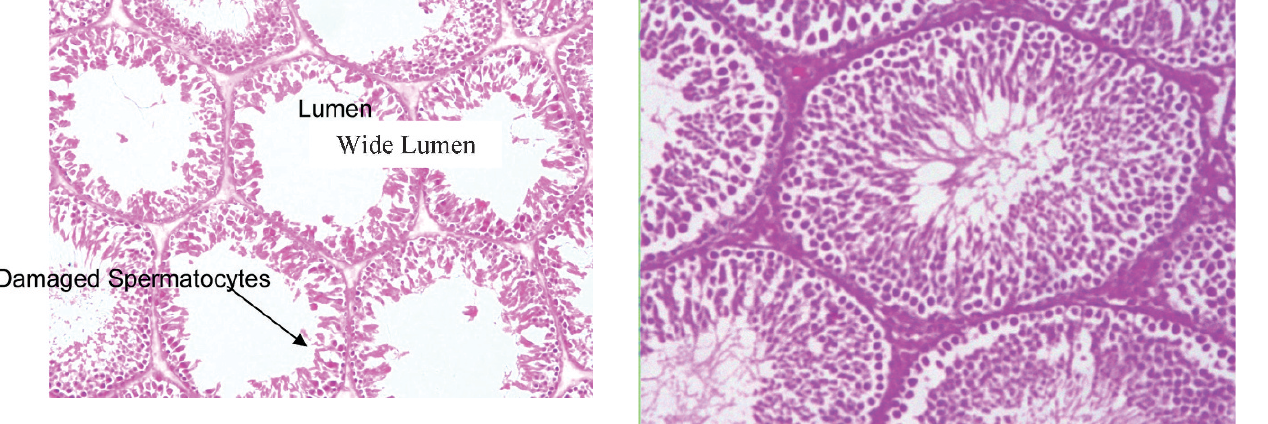
Figure 2 - Photograph of a section of rat testis exposed to EMR for 60 minutes showing the damaged spermatocytes and spermatids, marked mitotic divisions and pyknotic nuclei of some spermatogonia, widening of the seminiferous tubular lumen and absence of spermatozoa within the lumen. H&E 6 100.